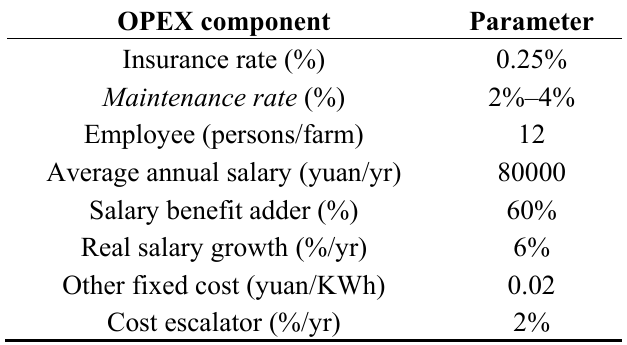
Table 3. The OPEX parameters of a 100-MW wind farm in